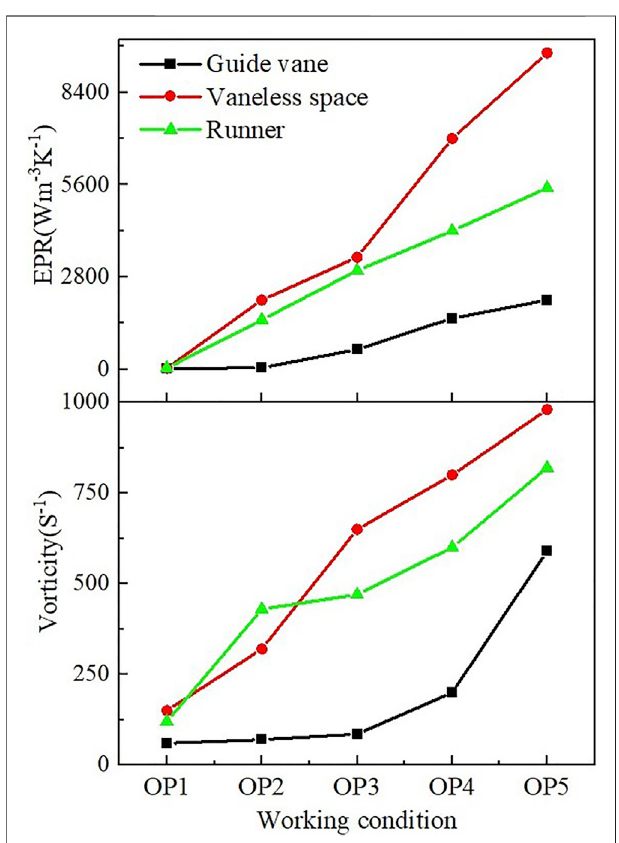
FIGURE 9 | Variations in vorticity and entropy production